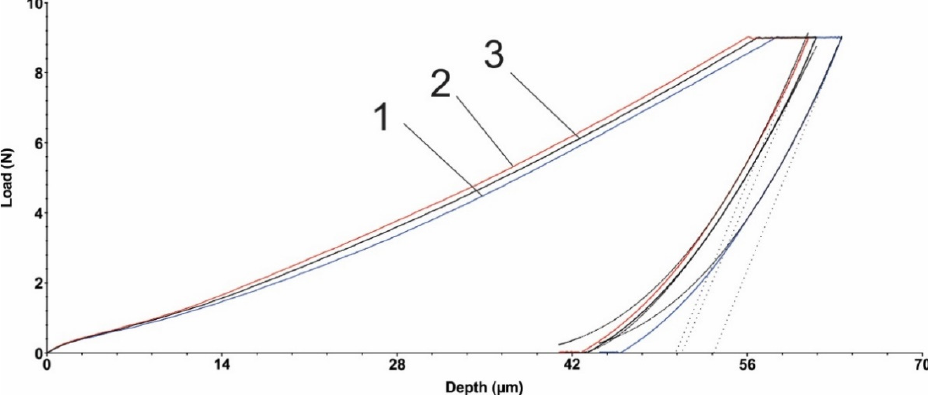
Figure 7. Square texture microindentation test (2 passes): 1, 2, 3—measurements.